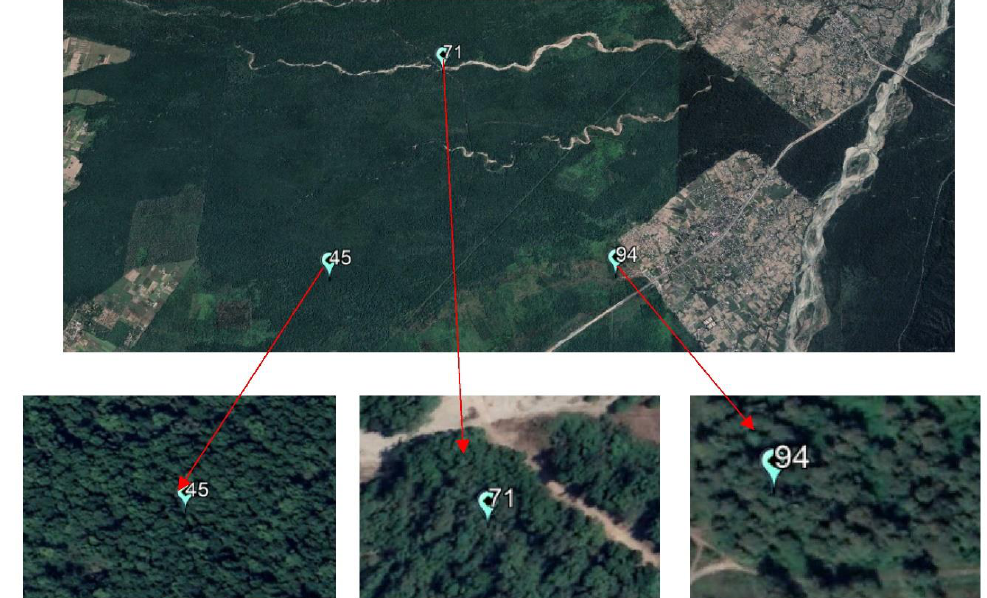
Figure 16. Google Earth view of plot numbers 45, 71, and 94.